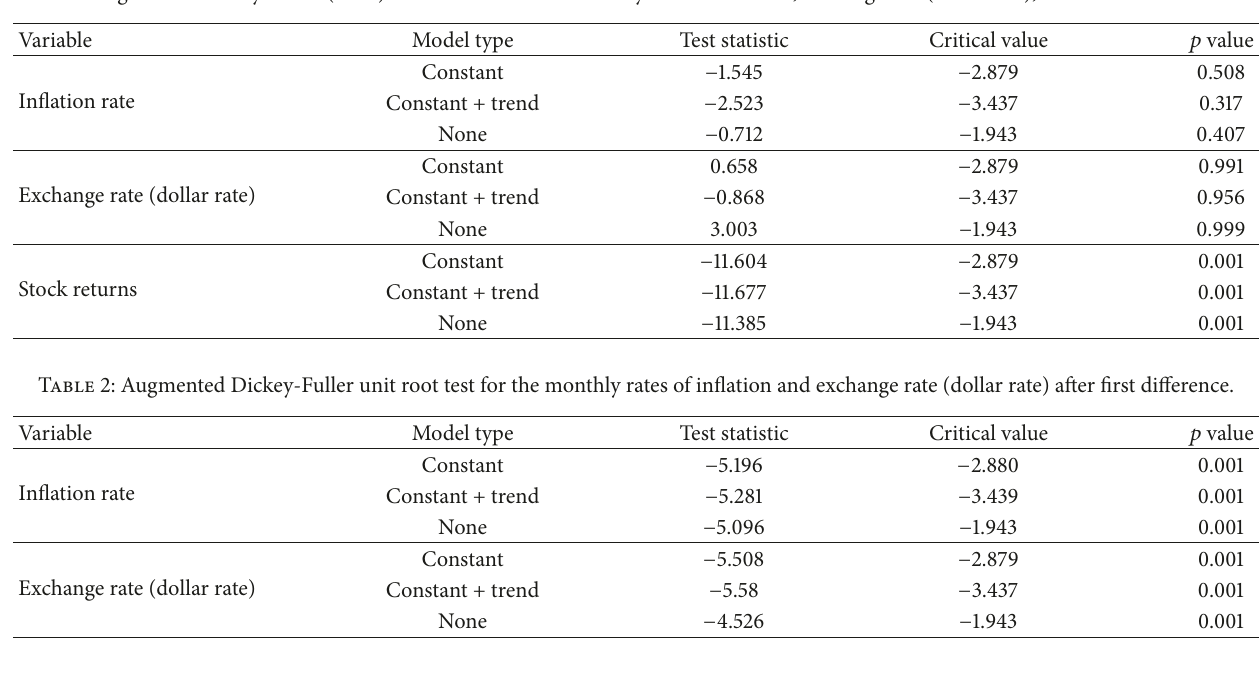
Table 1: Augmented Dickey-Fuller (ADF) unit root test for the monthly rates of inflation, exchange rate (dollar rate), and GSE market returns.